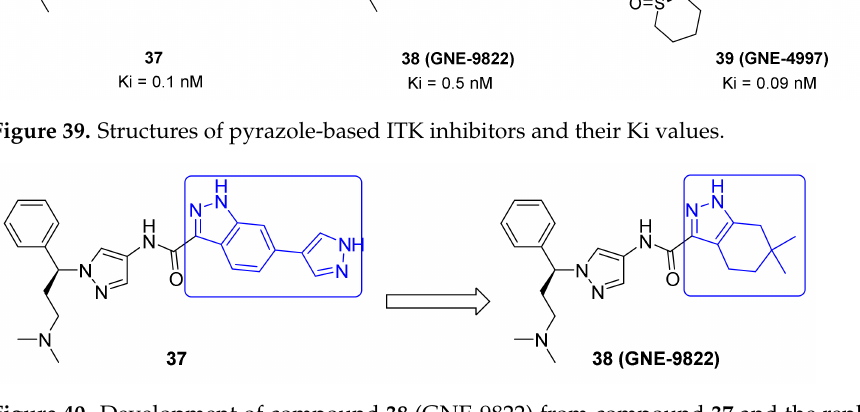
Figure 40. Development of compound 38 (GNE-9822) from compound 37 and the replacement of terminal 6-pyrazoloindazole with dimethyl-tetrahydroindazole.